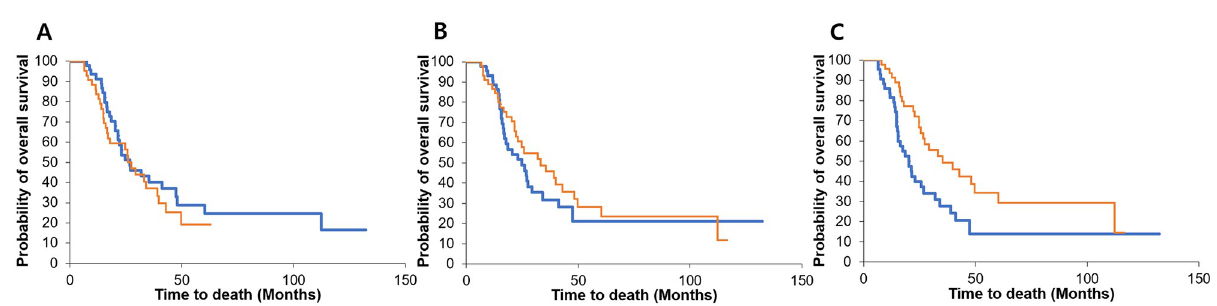
Fig 2. Survival according to the change in the skeletal muscle mass ratio (SMR). When we analyzed the SMR at each time point, there was no significant difference in the median overall survival (OS) between the higher and lower groups at 4 ( P = 0.488) and 12 ( P = 0.397) weeks after resection (A, B). However, the higher group showed a longer median OS than the lower group at 24 weeks (39 vs. 20 months, P = 0.008) (C).